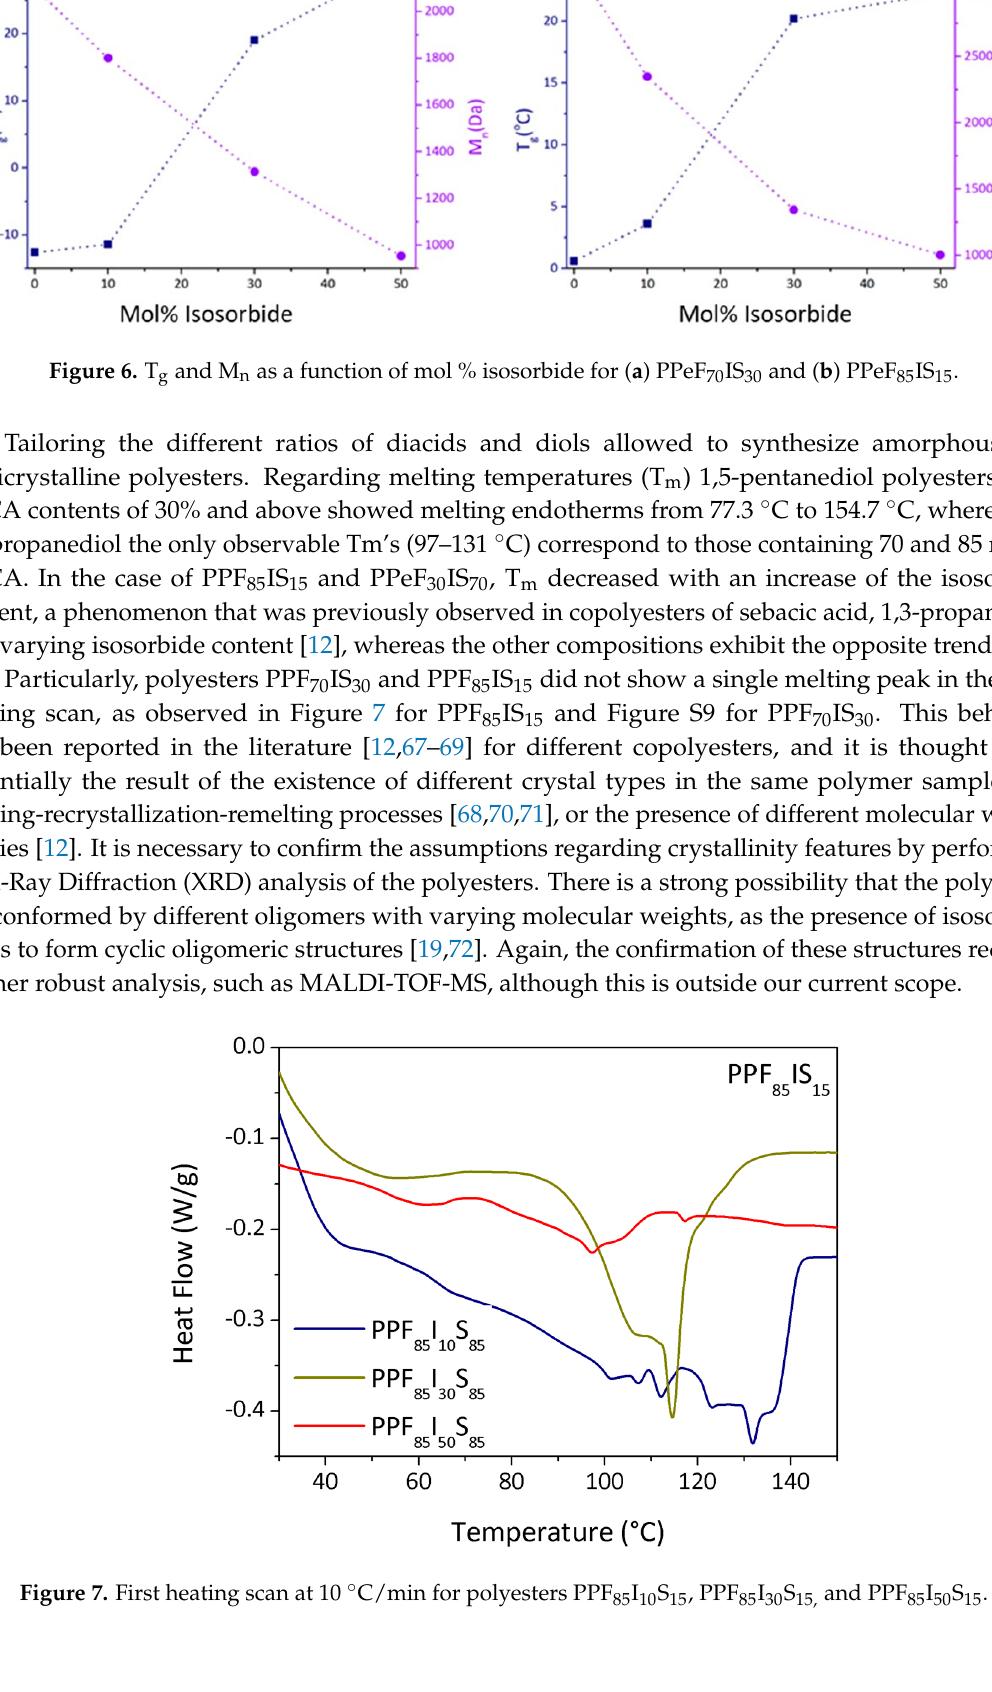
85 I 10 S 15 , PPF 85 I 30 S 15, and PPF 85 I 50 S 15